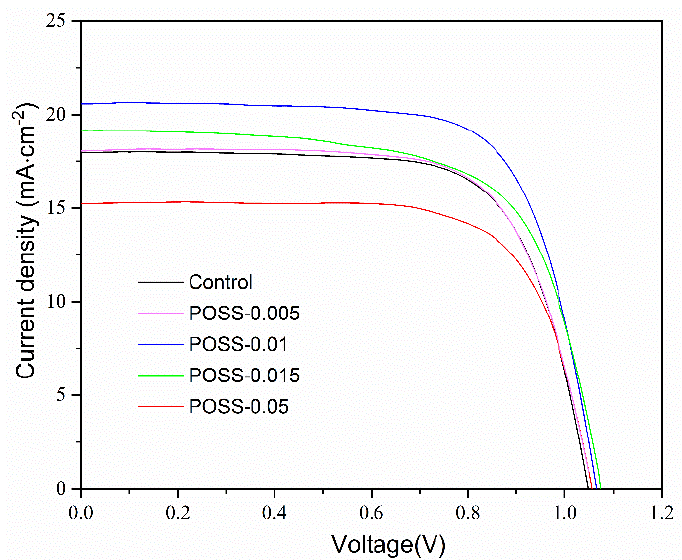
Figure 6. Current–voltage characteristics of the control cell and the PSC fabricated with various POSS contents. Table 1. The photovoltaic characteristics of the control cell and the PSC fabricated with various POSS contents.